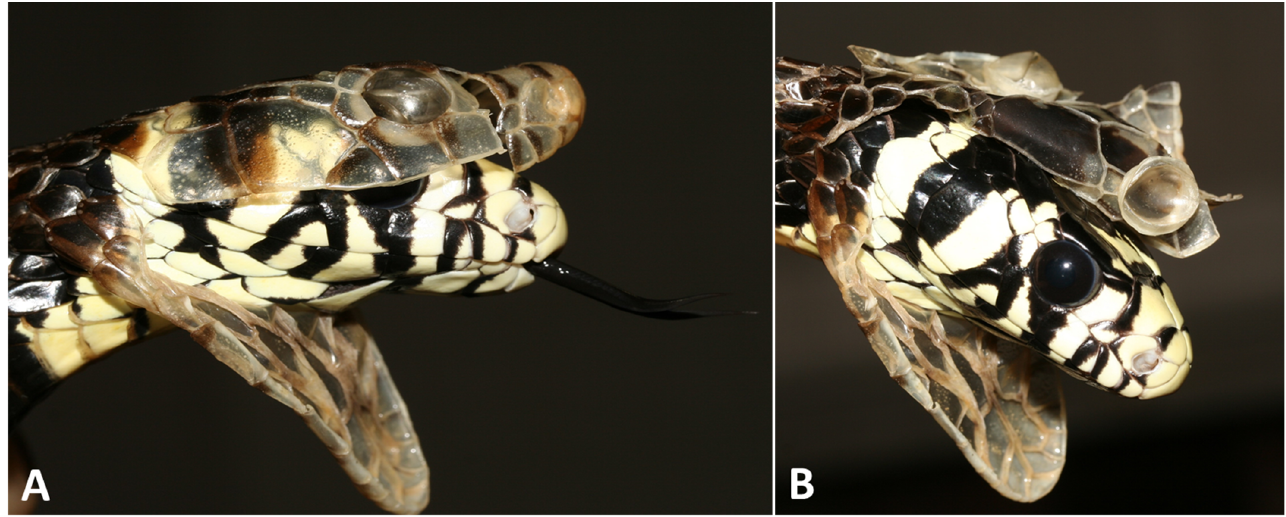
Figure 8. Ecdysis in a chicken snake ( Spilotes pullatus ). ( A ) Sloughing of the skin in a healthy snake should always occur in a single piece and include the spectacles. ( B ) The shed spectacle and its transition to the sloughed skin of the head are clearly visible and resemble a cast of the newly formed spectacle.